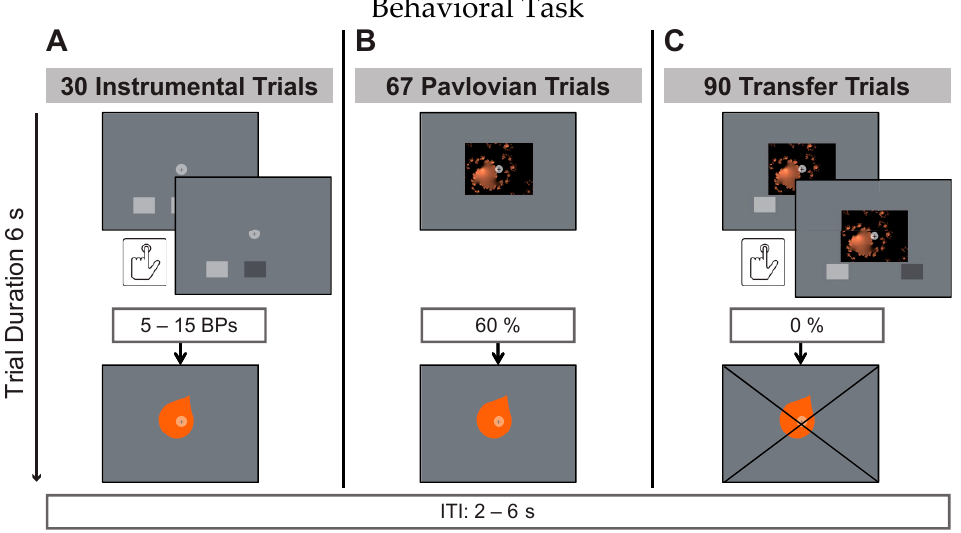
Figure 1. Example trials of the instrumental ( A ), Pavlovian ( B ) and transfer ( C ) phases with respective reward probabilities. Each button and visual cue was stably associated with one taste. The inter-trial-interval (ITI) had a pseudorandomized duration between 2-6s in all three phases.